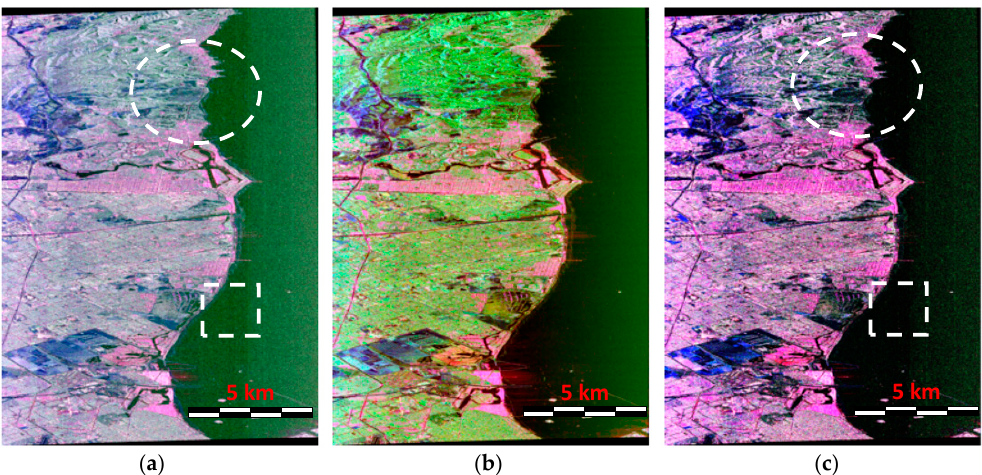
Figure 7 . Polarimetric decomposition results of the AIRSAR dataset by ( a ) the original MCSM method, ( b ) the Yamaguchi four-component method with rotated coherency matrix, and ( c ) our proposed improved MCSM decomposition method (red: P d ; green: P v ; blue: P s ).